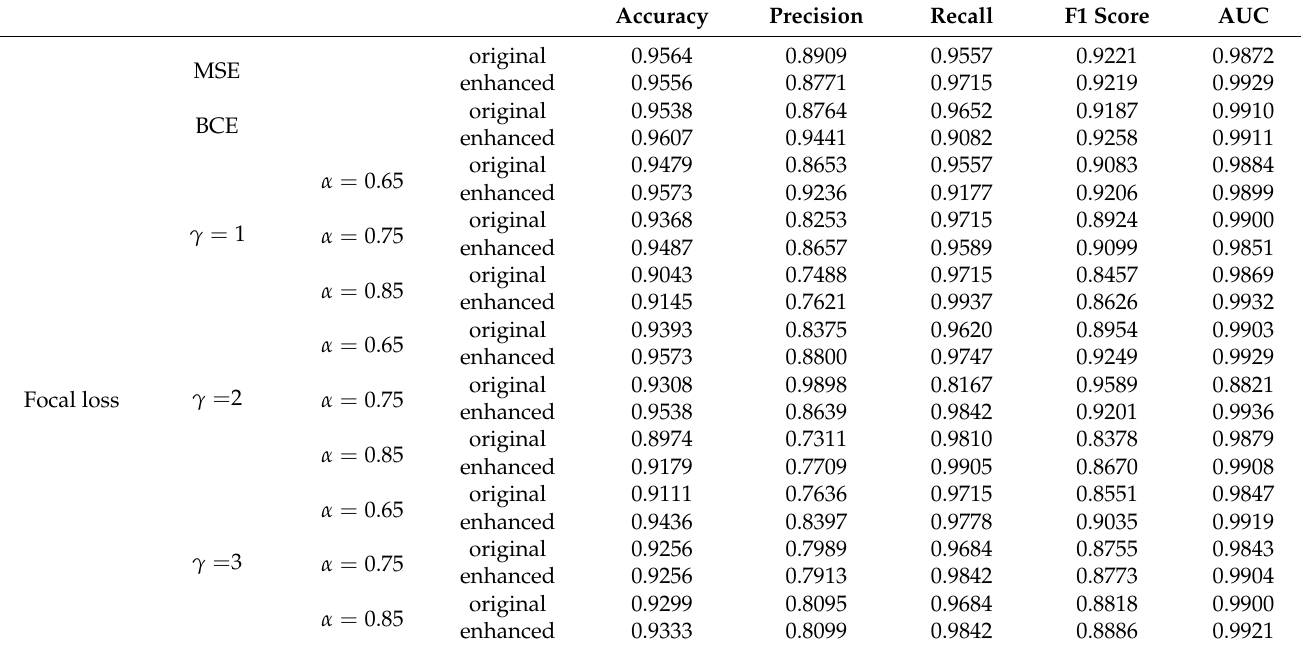
Table 6. Summary of performance of different loss functions with our proposed model and input shape